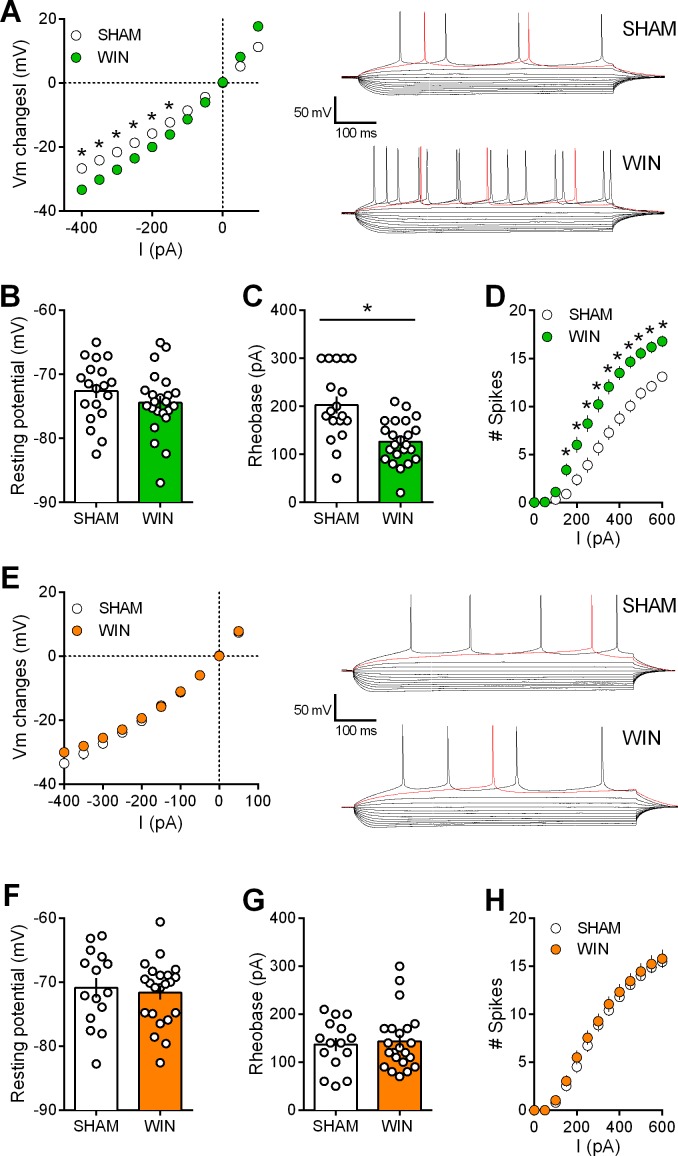
Prenatal WIN exposure induces sex-specific alteration of intrinsic properties of layer five prefrontal pyramidal neurons in adult rats.(A) Left, Current-voltage (I–V) curves recorded in SHAM (n = 19 cells/10 rats, white circles) and WIN-exposed rats (n = 23 cells/12 rats, green circles) showing altered membrane potentials in male from the in utero cannabinoid group (F(10, 400)=10.07, p<0.05, two-way ANOVA). Right, typical membrane response to somatic current steps from SHAM (up) and WIN- (down) exposed male. (B) The resting membrane potential was similar in both SHAM and WIN male groups (p>0.05, Mann-Whitney U test). (C) The rheobase was reduced in WIN-exposed male rats compared to the SHAM male (p<0.05, Mann-Whitney U test). (D) The number of evoked action potentials in response to increasing depolarizing current steps was higher in WIN in-utero treated male compared to SHAM animals (F(18, 720)=6.652, p<0.05, two-way ANOVA). (E) Left, In contrast, I-V curves were similar in SHAM (n = 15 cells/9 rats, white circles) and WIN-exposed female (n = 22 cells/12 rats, orange circles; F(9, 315)=1.091, p>0.05, two-way ANOVA). Right, typical membrane response to somatic current steps from SHAM (up) and WIN- (down) exposed females. (F,G) The resting membrane potential and the rheobase were not impacted in females (F,G) p>0.05, Mann-Whitney U test). (H) The number of action potentials was not altered in females after an in utero treatment (F(12, 455)=0.079, p>0.05, two-way ANOVA). *p<0.05. Error bars represent SEM.